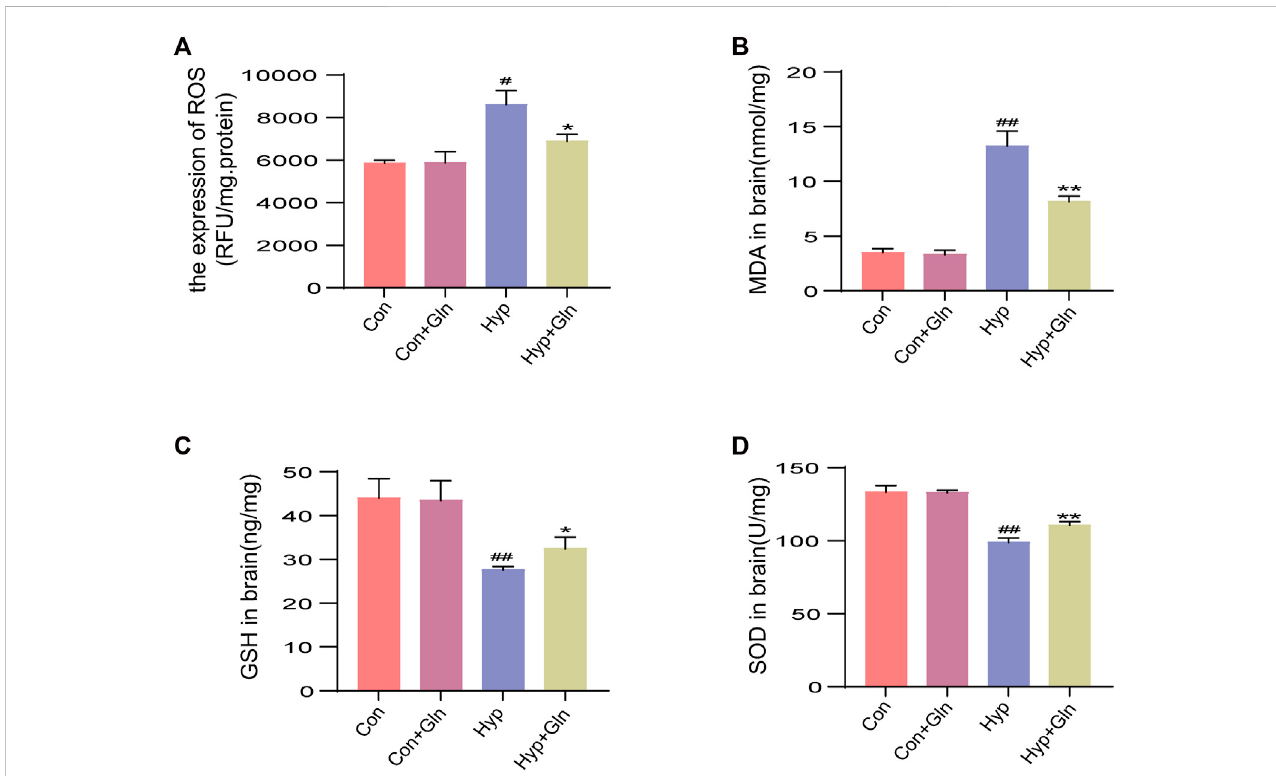
FIGURE 3 Gln improves oxidative stress after hyperoxia injury. (A) Total ROS content in hippocampus. Con (5851.05 ± 90.01), Con + Gln (5880.49 ± 303.02), Hyp (8160.46 ±380.24),Hyp+ Gln(6899.07 ±184.10). (B) MDAcontentinhippocampus.Con(3.50±0.21),Con+Gln(3.30±0.23), Hyp(13.23±0.78),Hyp+Gln (8.13 ± 0.29). (C) GSHcontent in hippocampus. Con(44.03± 2.54), Con + Gln(43.47 ± 2.58), Hyp (27.60± 0.44), Hyp + Gln(32.43 ± 1.53). (D) SOD content in hippocampus. Con (133.37 ± 2.49), Con + Gln (132.87 ± 1.00), Hyp (98.77 ± 1.78), Hyp + Gln (110.70 ± 1.36) ( n = 3). # p < 0.05, ## p < 0.01 vs. the Con, * p < 0.05, ** p < 0.01 vs. the Hyp. p < 0.05 was considered statistically signi fi